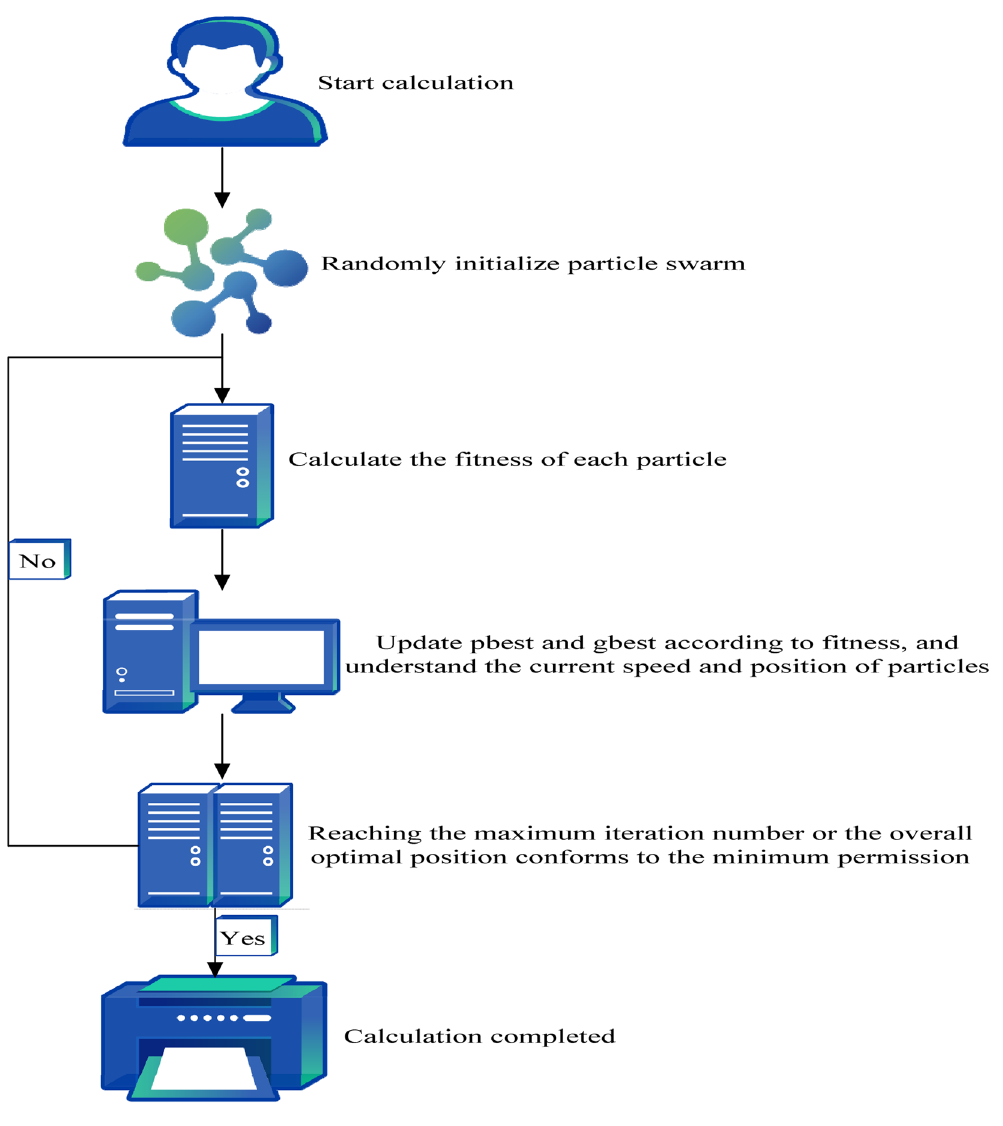
Fig. 2 Flow of PSO